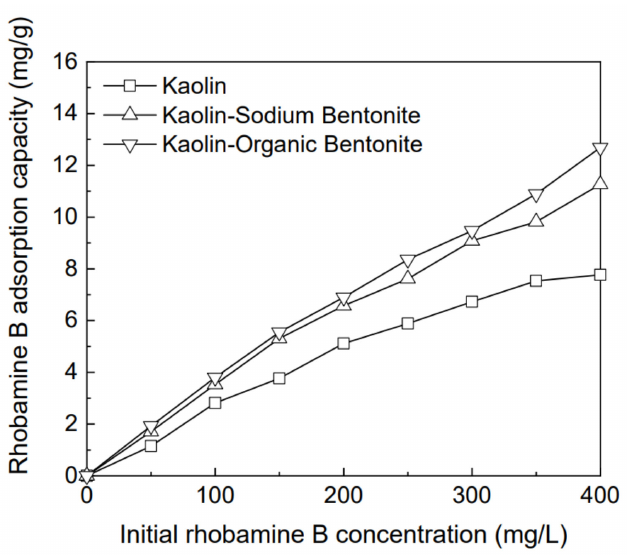
Figure 5. Effect of initial concentration of rhodamine B solution on removal of rhodamine B by different adsorbents.